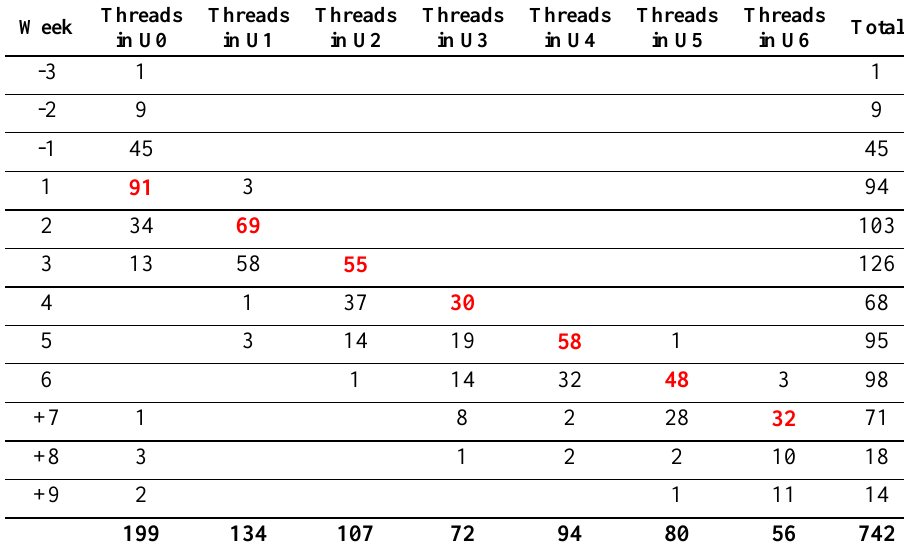
Discussions distribution in each